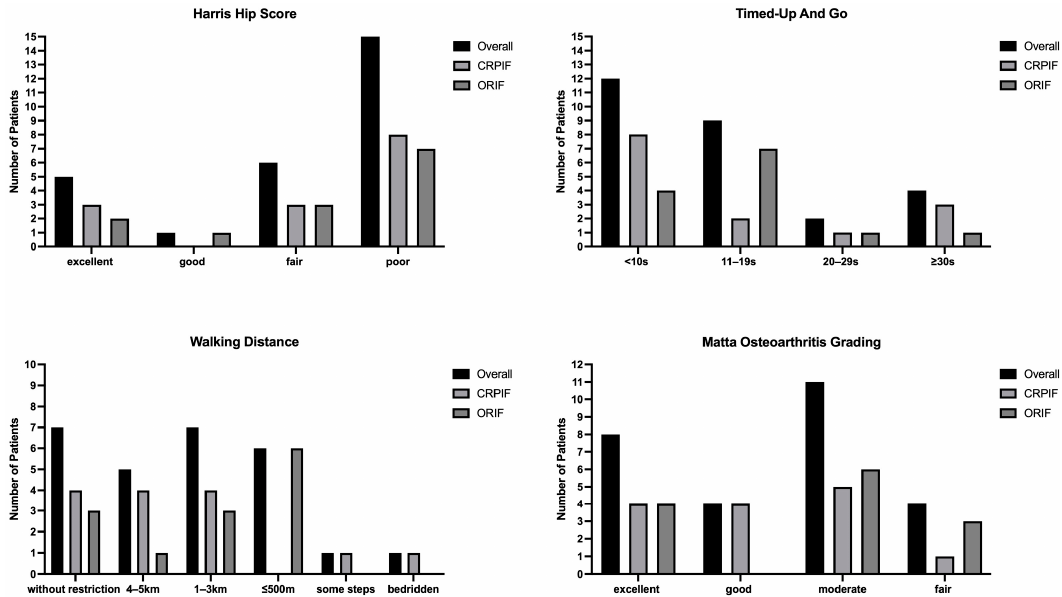
Figure 2. Distribution within the used scores without significant differences between the groups.